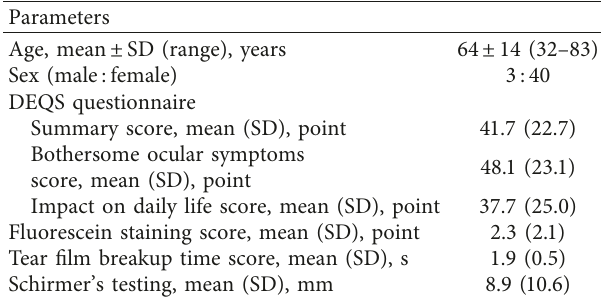
Table 1: Characteristics of participants before initiating the RBM